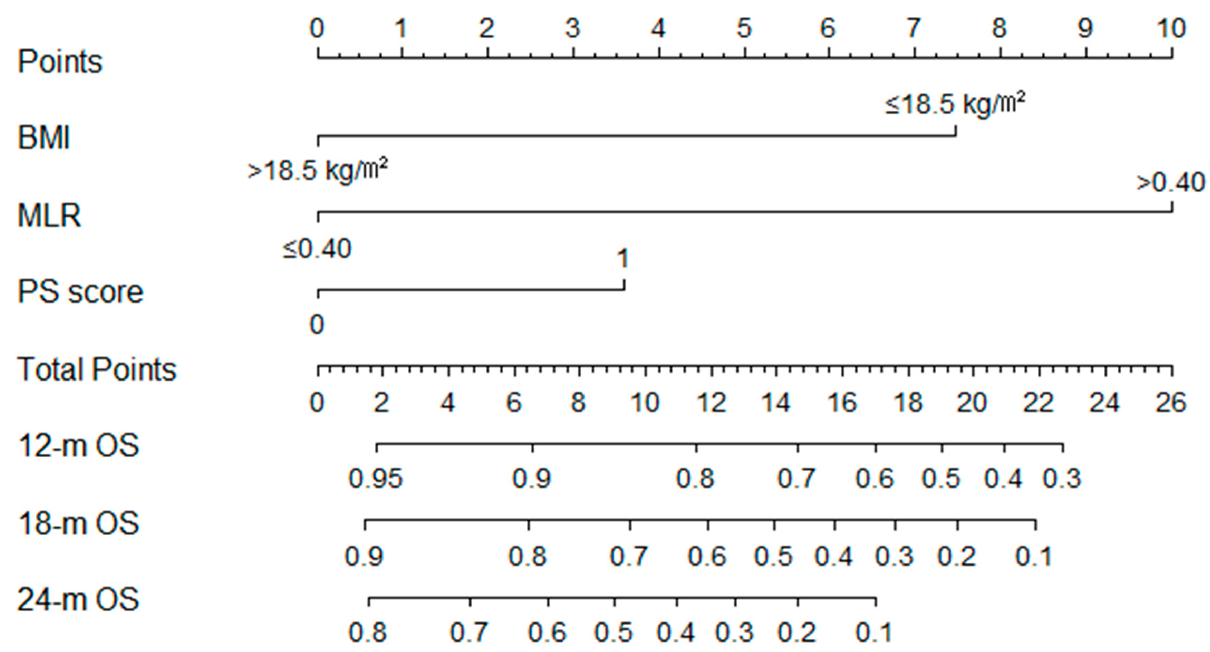
Figure 3. Nomogram for OS predicted the 12-, 18-, and 24-month survival probabilities. Abbreviations: BMI, body mass index; MLR, monocyte-to-lymphocyte ratio; PS score, performance status score; OS, overall survival.